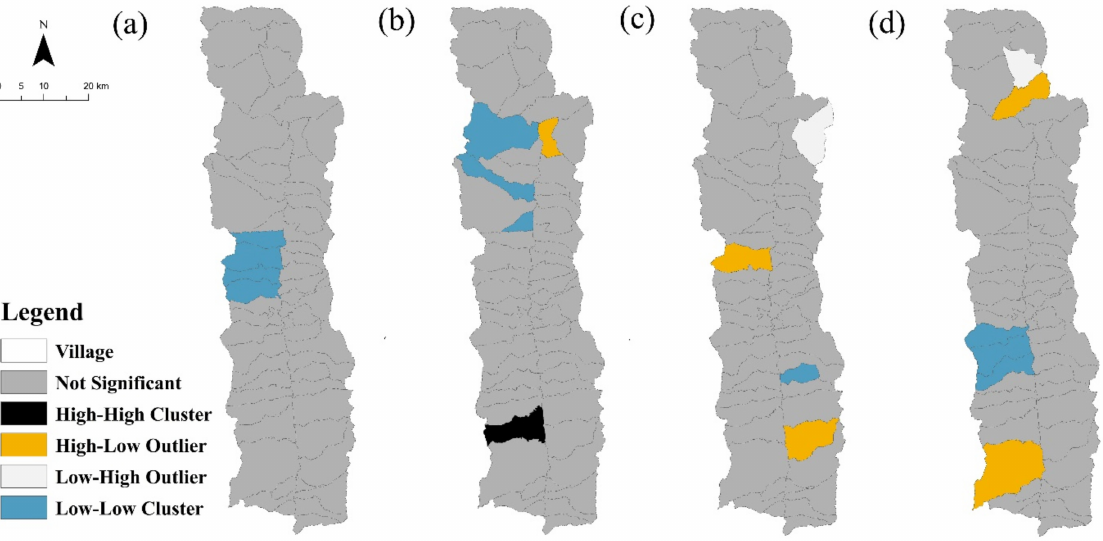
Figure 6. Lisa diagram chart of OLS residual terms of the village-level factors from 2015 to 2018 ( a – d ).